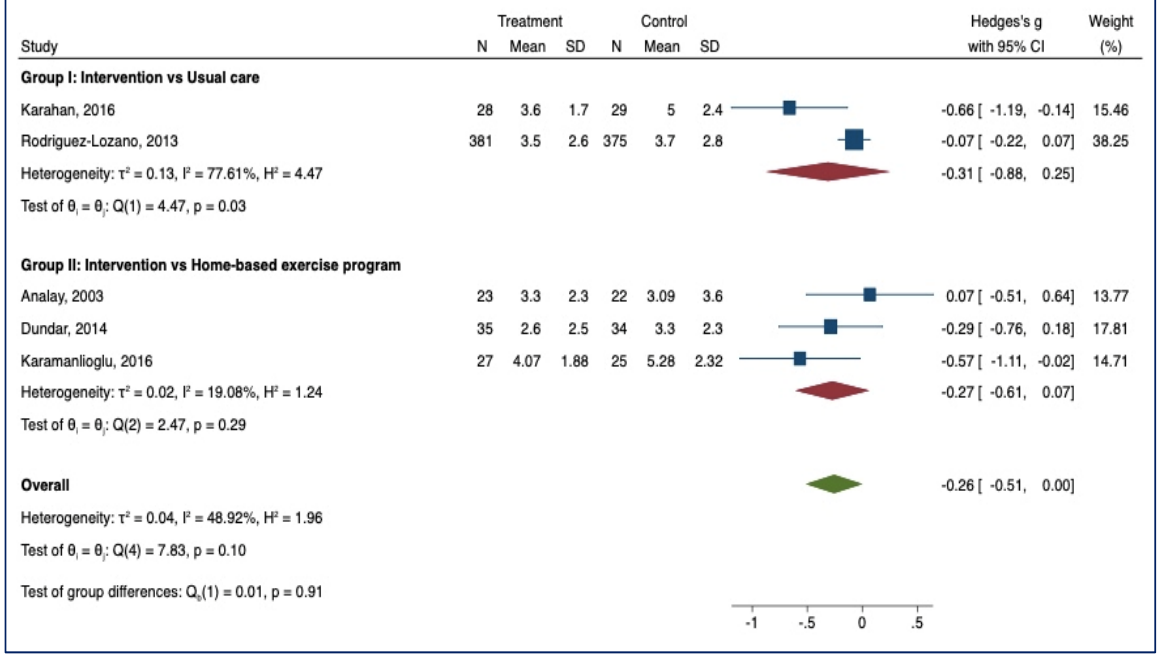
Figure 6. VAS—Forest Plot.